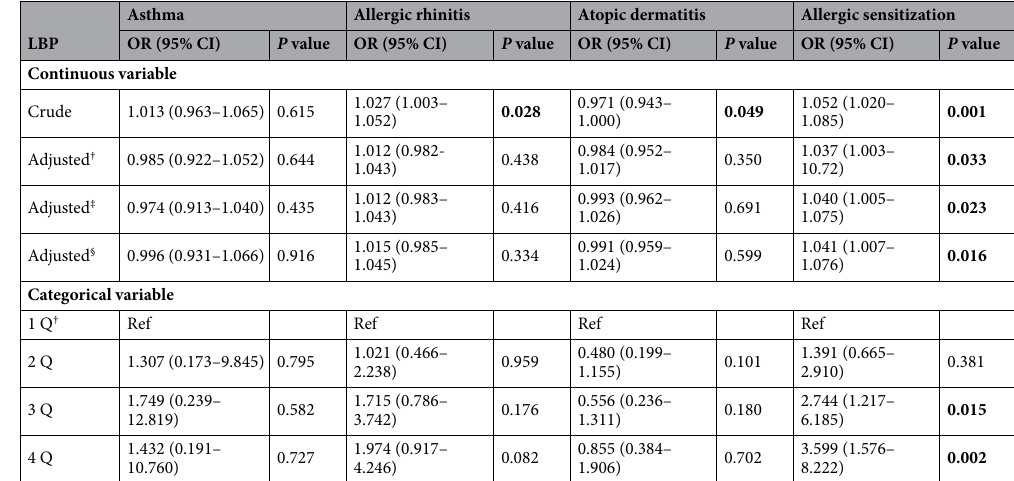
Table 1. Association of serum LBP level, as a continuous variable (top) and a categorical variable (bottom), with asthma, allergic rhinitis, atopic dermatitis, and allergic sensitization * . Allergic sensitization indicates one or more positive reactions (wheal diameter > 3 mm) to any allergen in the SPT. CI confidence interval, OR odds ratio, LBP lipopolysaccharide-binding protein. *Analyses are based on the 356 subjects using data on allergic sensitization (19 with asthma, 167 with allergic rhinitis, 80 with atopic dermatitis, and 249 with allergic sensitization). OR was calculated using generalized linear regression with the logitfunction. † Multivariate logistic regression adjusted for sex, age, body mass index z-score, parental asthma, allergic rhinitis, and atopic dermatitis, and household income (model I). ‡ Multivariate logistic regression adjusted for sex, age, body mass index z-score, parental asthma, allergic rhinitis, and atopic dermatitis, and type of residency (model II). § Multivariate logistic regression adjusted for sex, age, body mass index z-score, parental asthma, allergic rhinitis, and atopic dermatitis, and floor of residency (model III).